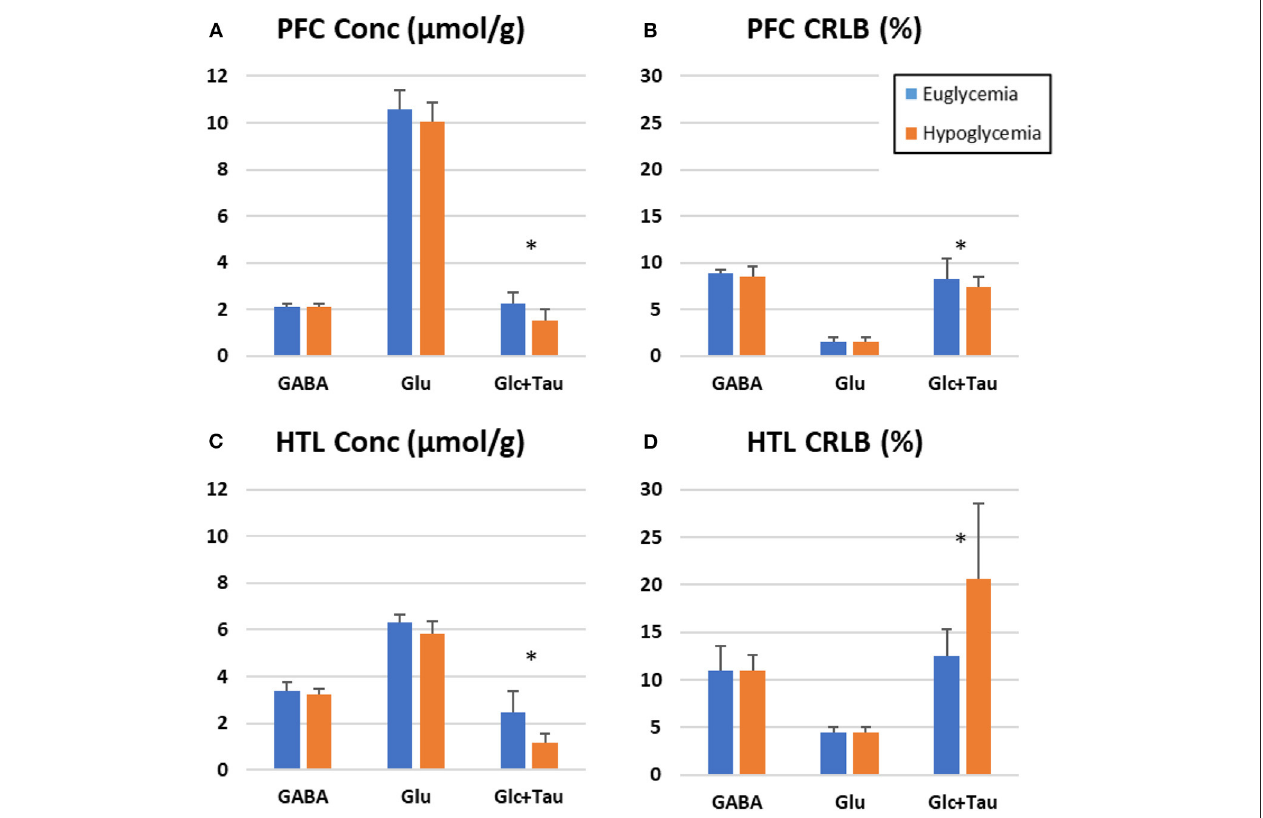
FIGURE 8 | LC Model estimation of metabolites-of-interest for prefrontal cortex (PFC, A,B ) and hypothalamus (HTL, C,D ) during euglycemic and hypoglycemic glucose clamps-bar graph represents the mean value across participants ( N = 6) with error bars representing the standard deviation. (Stars indicate p < 0.05, paired 2-tailed t